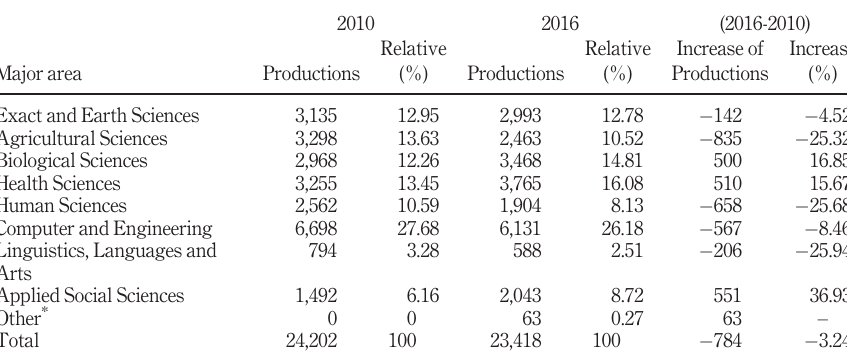
Table III. Technical